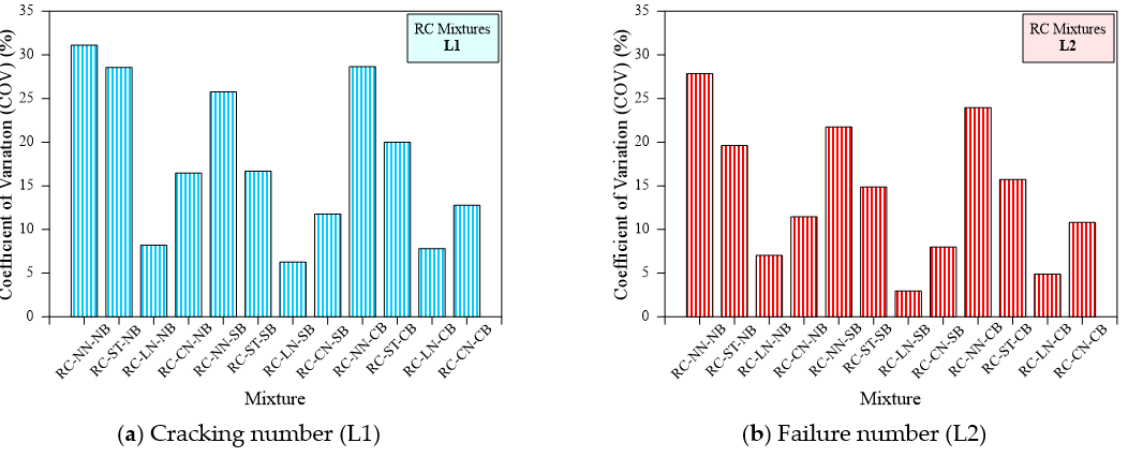
Figure 19. Coefficient of variation of cracking and failure impact numbers of RC specimens ( a ) Cracking number (L1), ( b ) Failure number